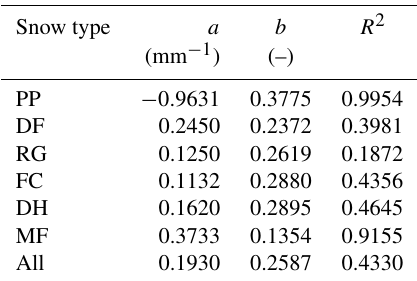
Table A1. Regression coefficients for Fig. A1. All data within a snow type class were fitted to Q REG = a · d + b , where d is given in millimetres. When several grain types coexist, the dominant type is listed first.